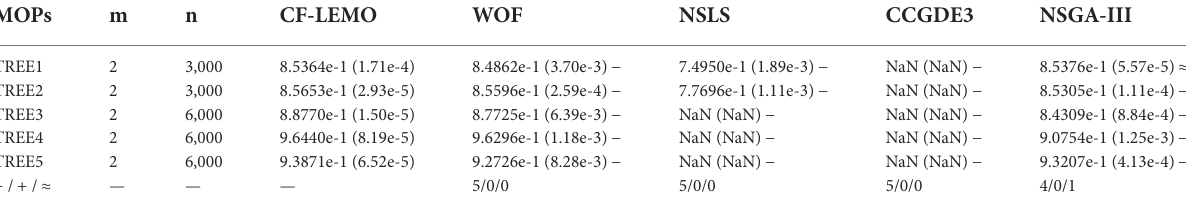
TABLE 2 HVvaluesofthefivealgorithmsonsolvingTREE1-TREE6.